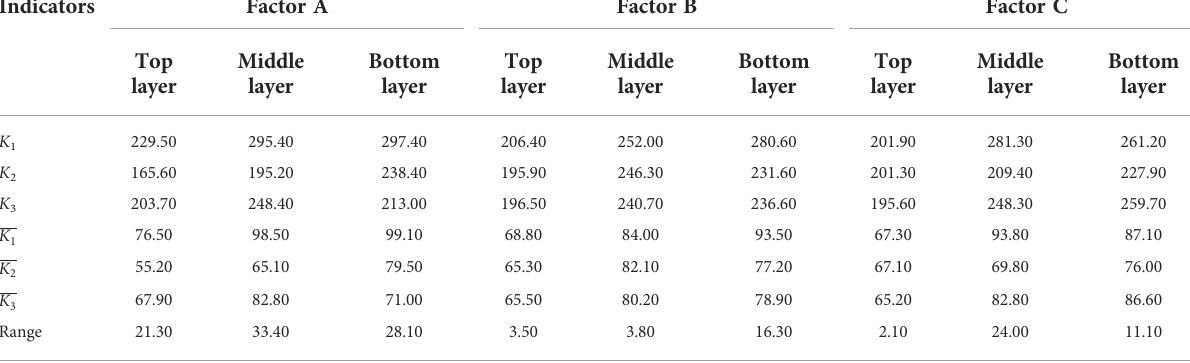
TABLE 6 Canopy vertical longitudinal droplet deposition density range analysis.